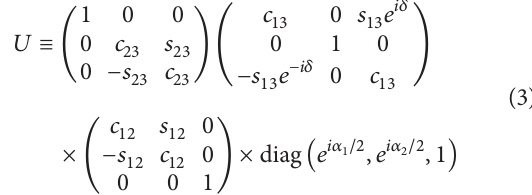
Figure 2: Rotations between mass and flavor eigenstates in the 3 families neutrino oscillation scheme ( 𝜃 23 ∼ 45 ∘ , 𝜃 12 ∼ 40 ∘ , and 𝜃 13 < 9 ∘